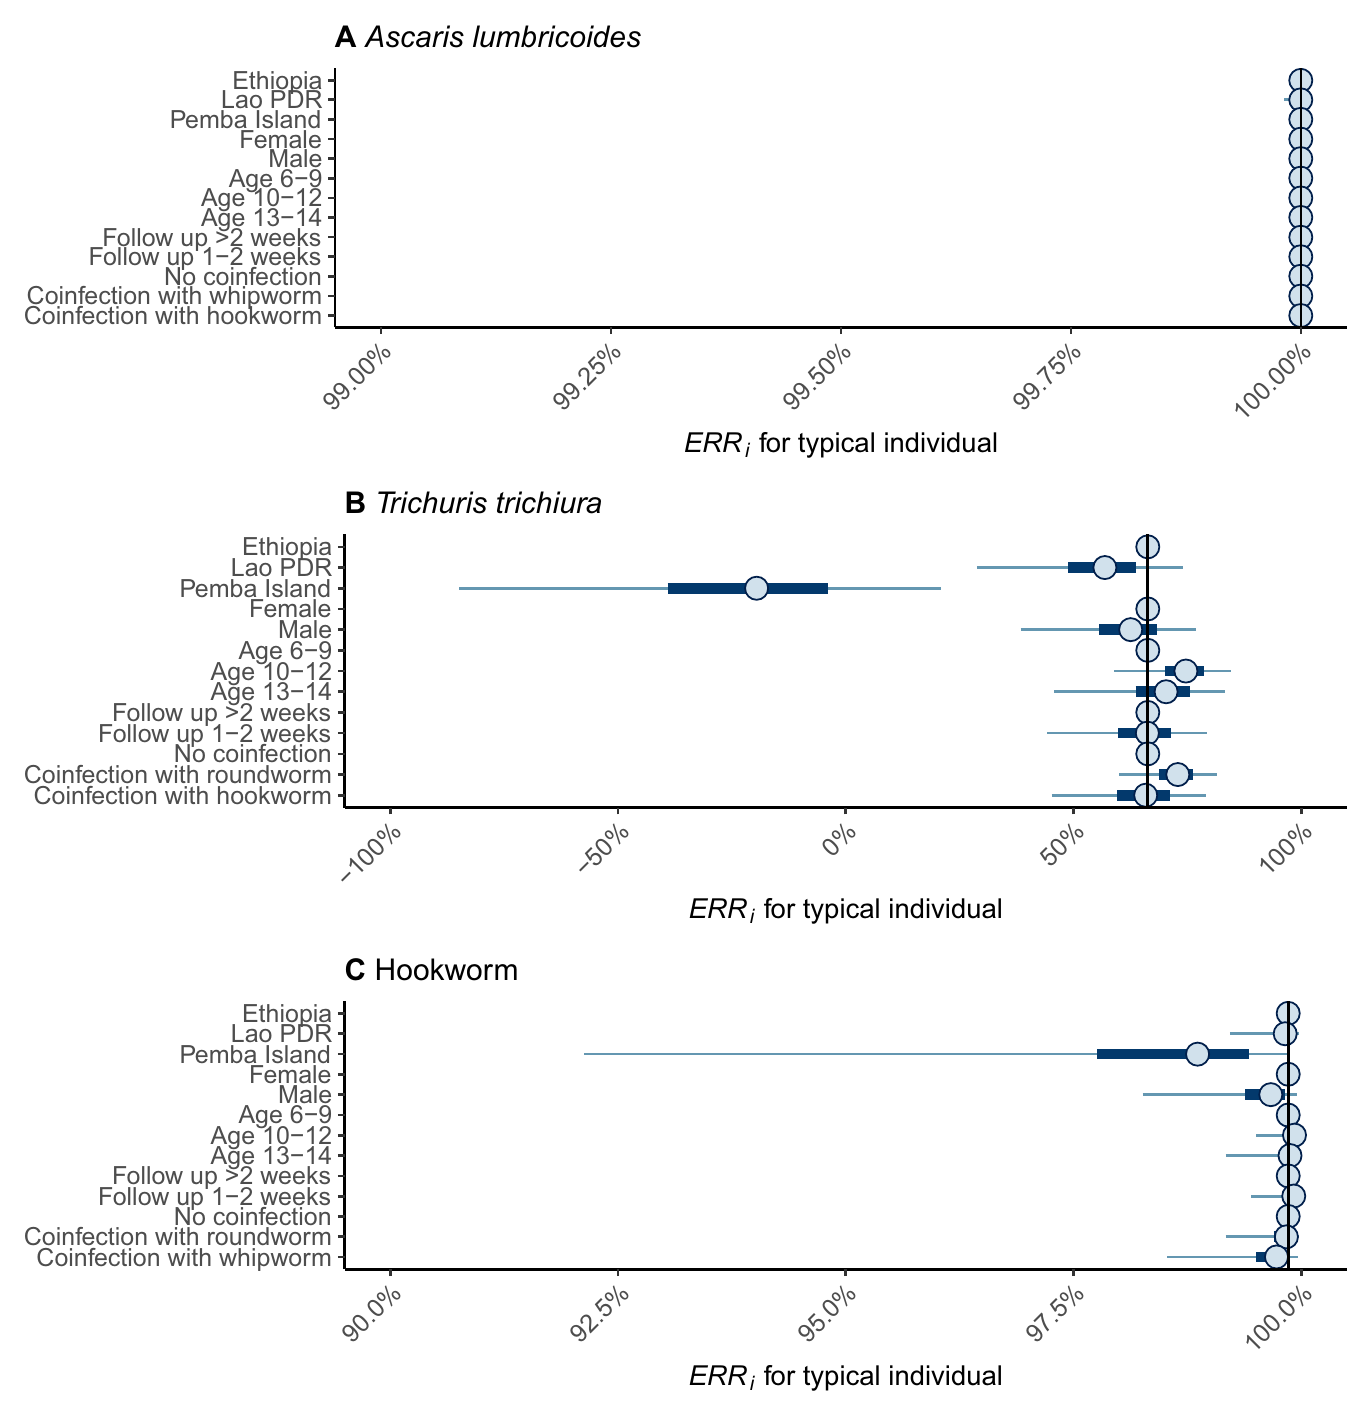
Fig 4. Influence of fixed effects coefficients on the efficacy of albendazole against soil-transmitted helminth infections. Individual egg reduction rates, ERR estimated by fitting the Bayesian model [15,16,21]to fecal egg count data on Ascaris lumbricoides ( panel A ), Trichuris trichiura ( panel B ) and hookworm ( panel C ) collected before and after administration of a single 400 mg oral dose of albendazole in three study sites, Ethiopia, Lao PDR and Pemba Island (Tanzania). Points, horizontal thick and thin lines indicate the median, the 50% and the 95% credible interval respectively. The reference ERR categories of Ethiopia, female, age 6–9 years, follow up > 2 weeks and no coinfection) is indicated by the solid vertical line. All estimates correspond to the ERR i associated with a ‘typical individual’ (i.e., with random effects terms set to